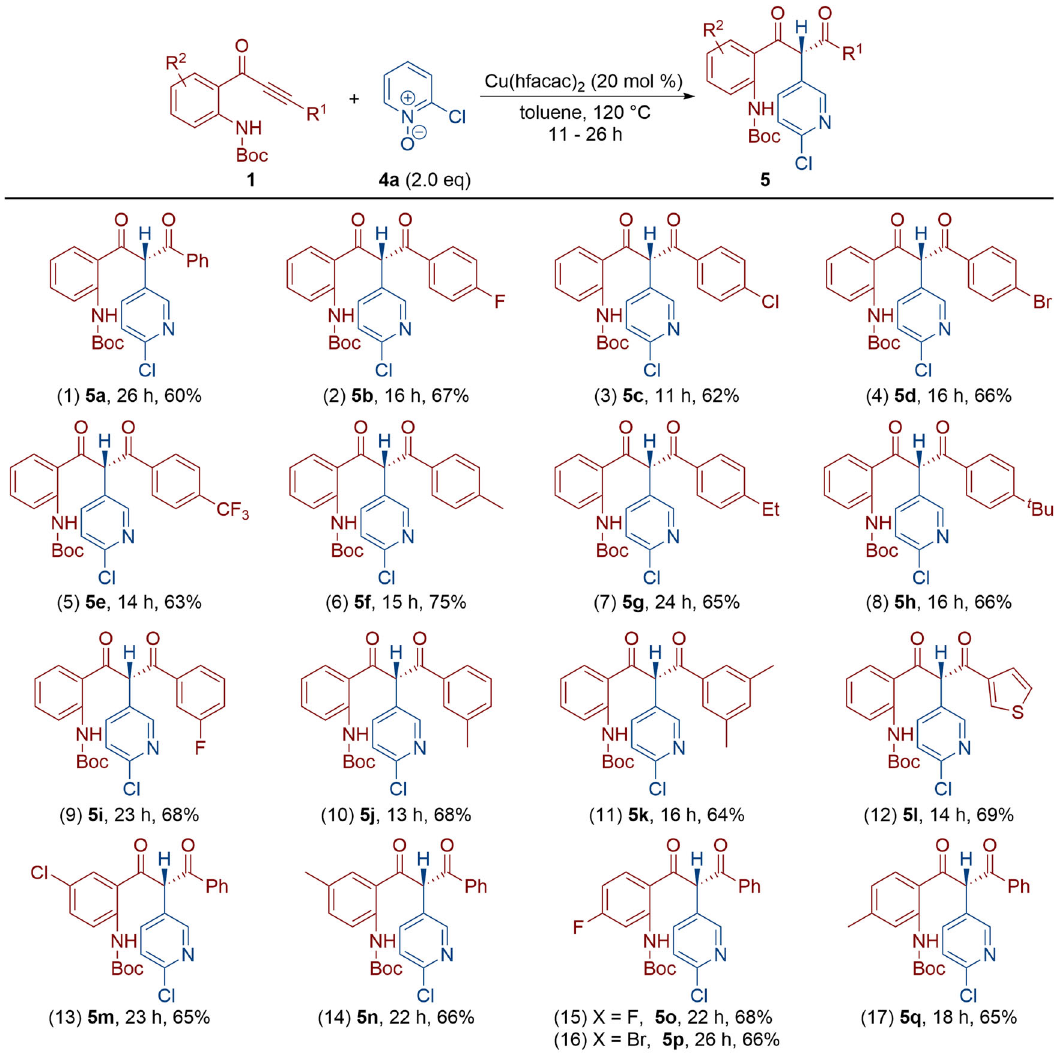
Fig. 4 Reaction scope for the formation of pyridine-based diones 5. Reaction conditions: [ 1 ] = 0.05 M; yields are those for the isolated